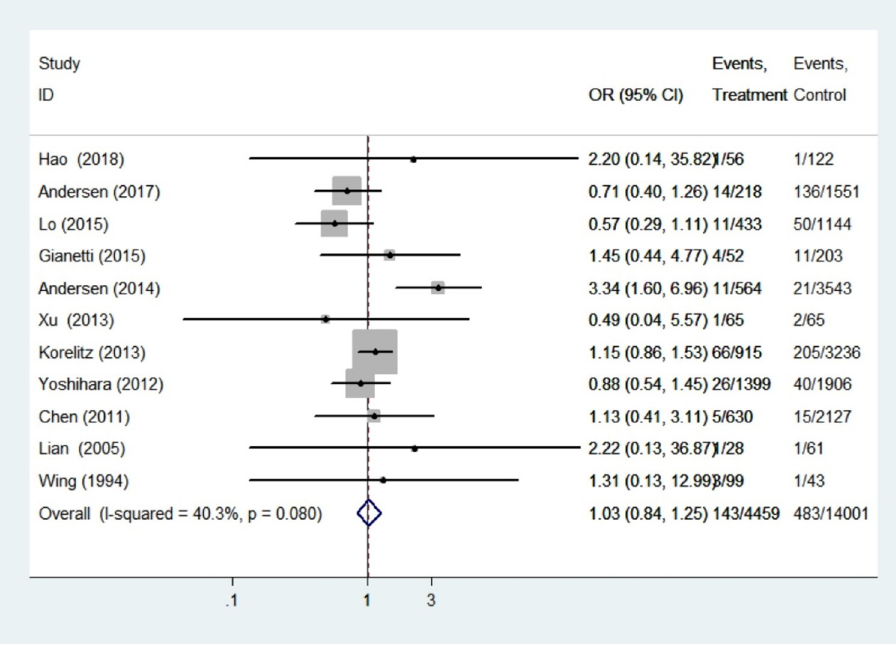
Fig 4. Forest plots of showing the effects of PTU on congenital